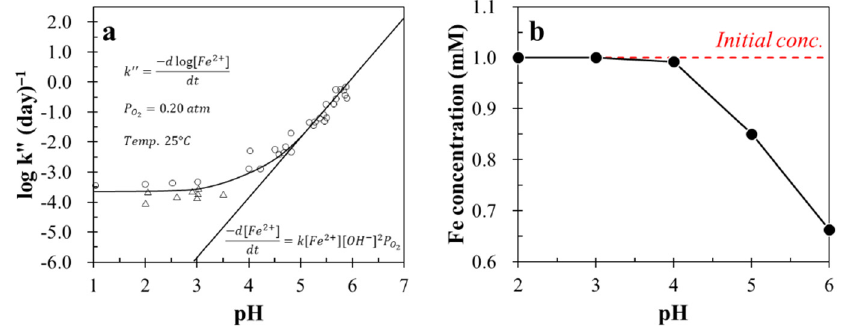
Figure 2. ( a ) Oxidation rate of ferrous iron species as a function of pH (reprinted with permission from Morgan and Lahav [29], copyright (2007) Elsevier) and ( b ) the change in dissolved Fe concentration ([Fe 2+ ] initial = 1 mmol/L) in the presence of 1 mmol/L PO 43 − as a function of pH.